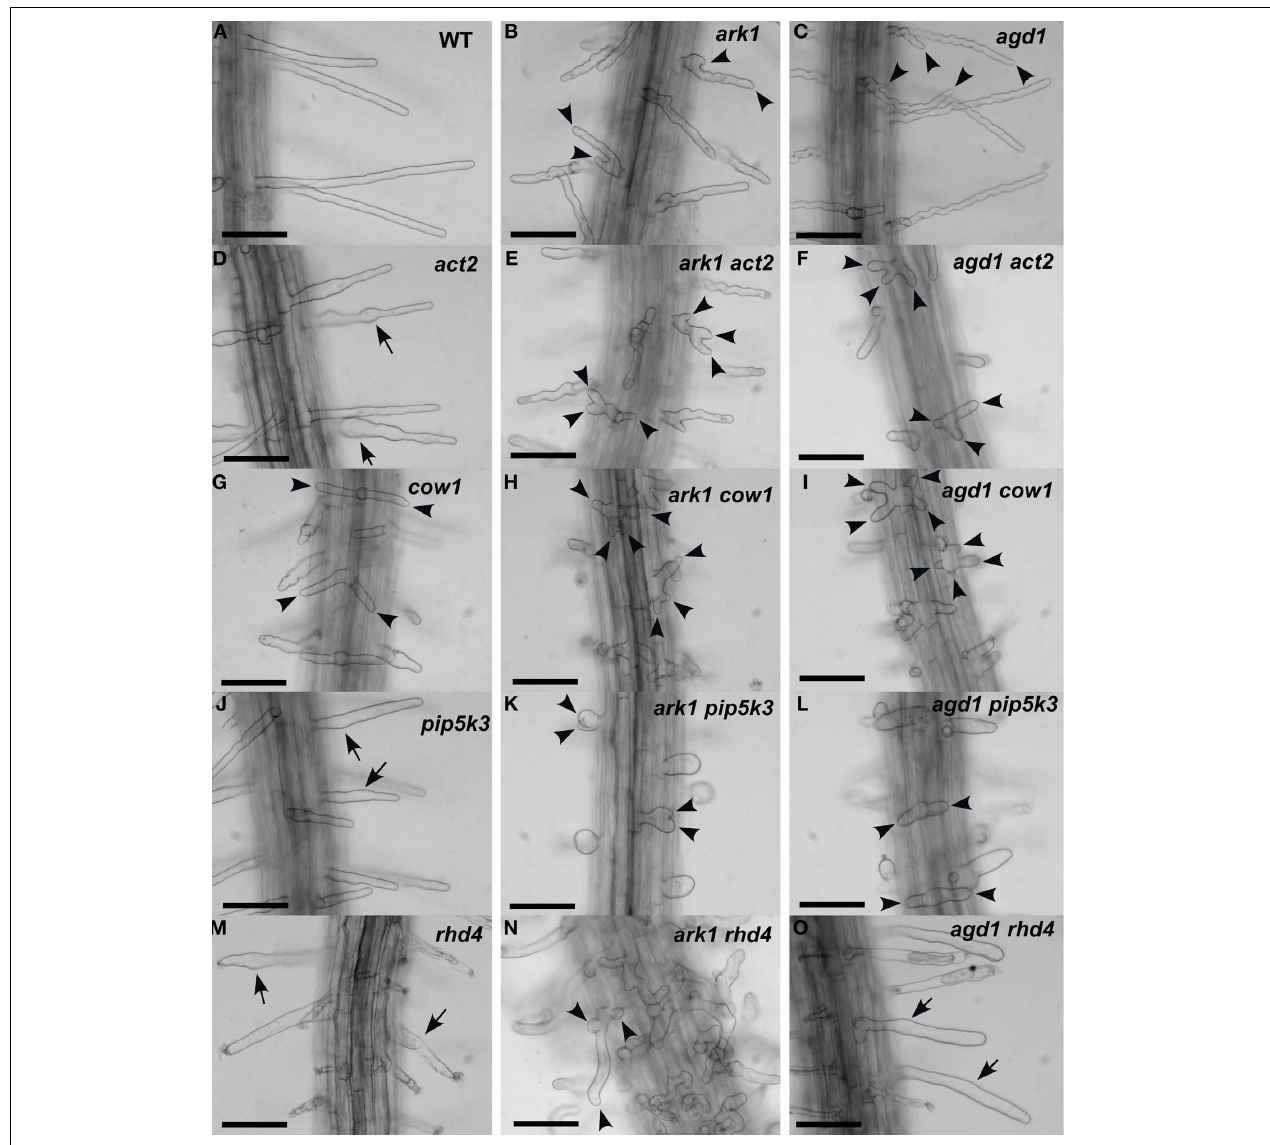
FIGURE 1 | Root hair phenotypes of ark1, agd1 and their respective double mutants. (A–C) Wild-type and ark1 , and agd1 root hairs. (D,G,J,M) Root hairs of single act2 , cow1 , pip5k3, and rhd4 mutants. (E,H,K,N) Root hairs of double mutants with ark1 .